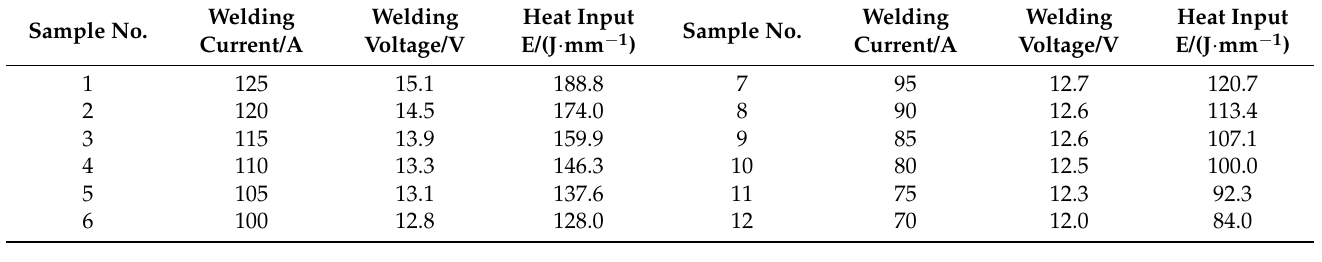
Table 2. Weld parameters of 2A14 aluminum alloy and ER2319 filler metal.